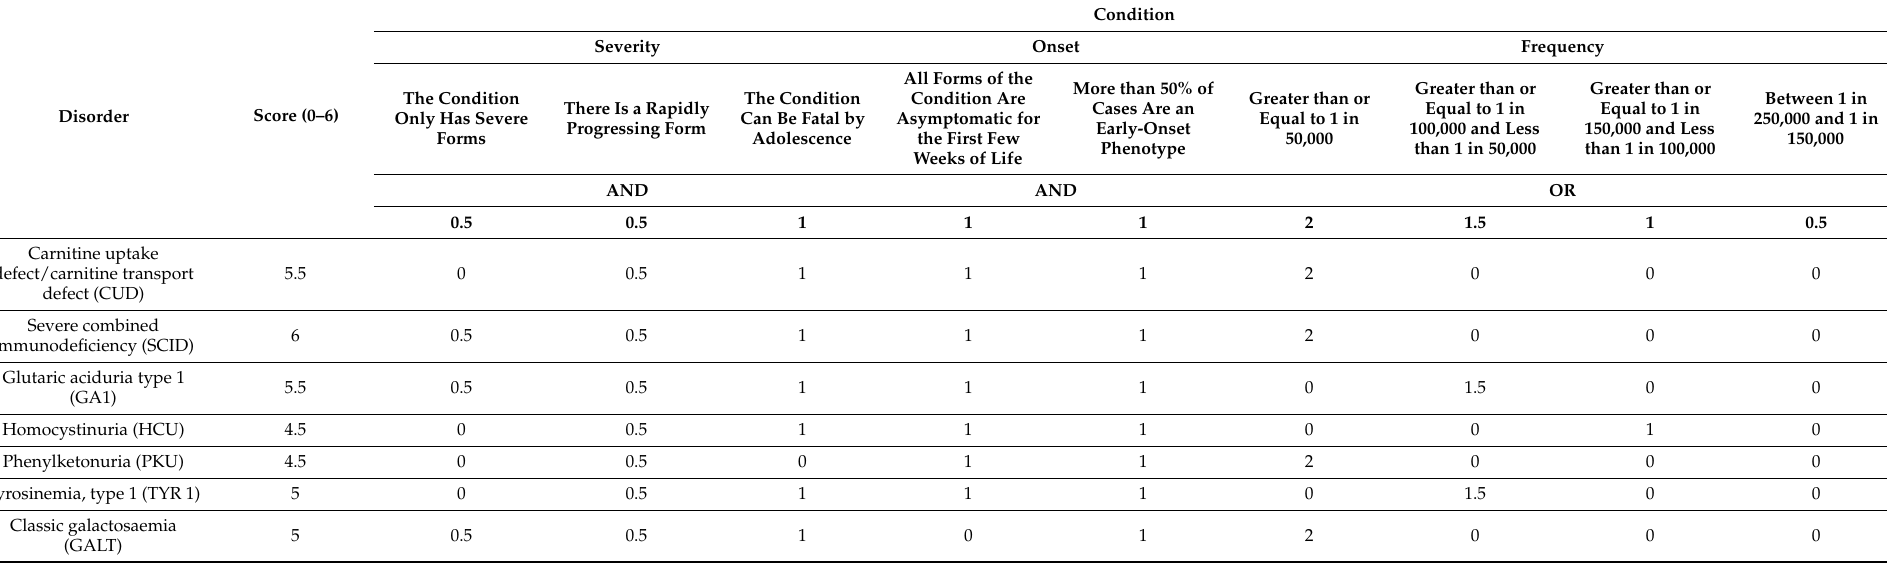
Table A2. Scoring of IMDs using the NBS evaluation algorithm: pillar Condition